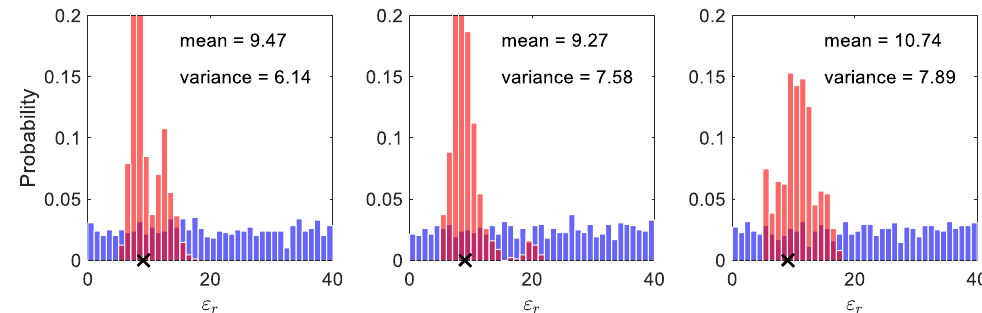
Figure 5. Histograms of the prior (blue bars) and posterior (red bars) distribution of three randomly selected parameters derived from Bayesian inversion using the finite-difference time-domain (FDTD) forward model with first-arrival traveltime data. The true values of the parameters are denoted with black